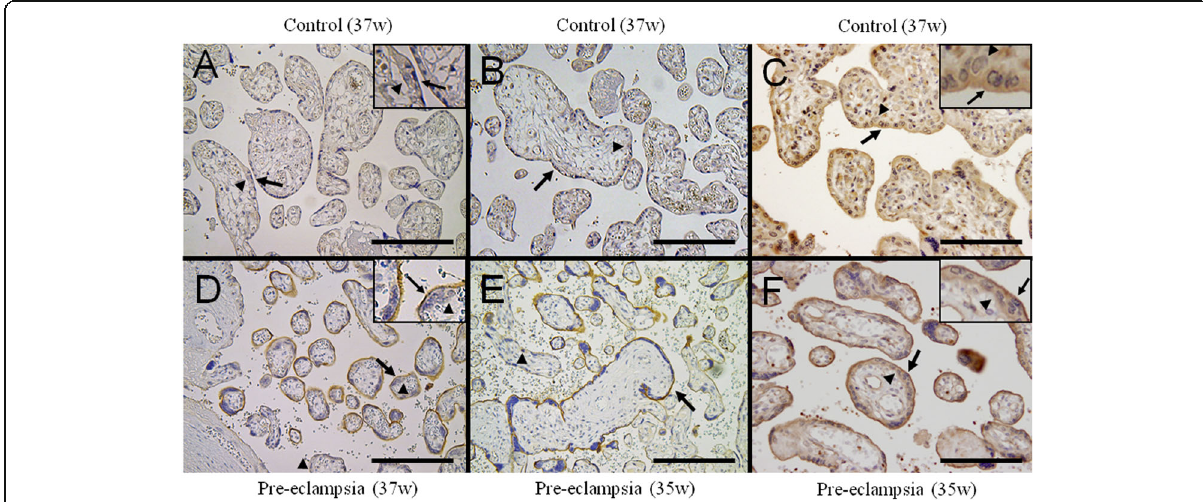
Fig. 3 Nectin-4 immunostaining of placental tissue sections. Polyclonal rabbit antibodies raised against the cytoplasmic domain of the human nectin-4 ( a , b , d and e ) or polyclonal goat antibodies raised against the C-terminal domain of the human nectin-4 ( c and f ) were used. Positive staining was apparent in the cytoplasm and cell membrane at the apical side of the syncytiotrophoblasts (arrows). Cytotrophoblasts were also positive (arrowheads, insets). The nectin-4 signals were much stronger in pre-eclampsia ( d , e and f ) compared with uncomplicated normotensive pregnancy ( a , b , and c ). Original magnifications a-f : 400 x. Scale bars, 100 μ m